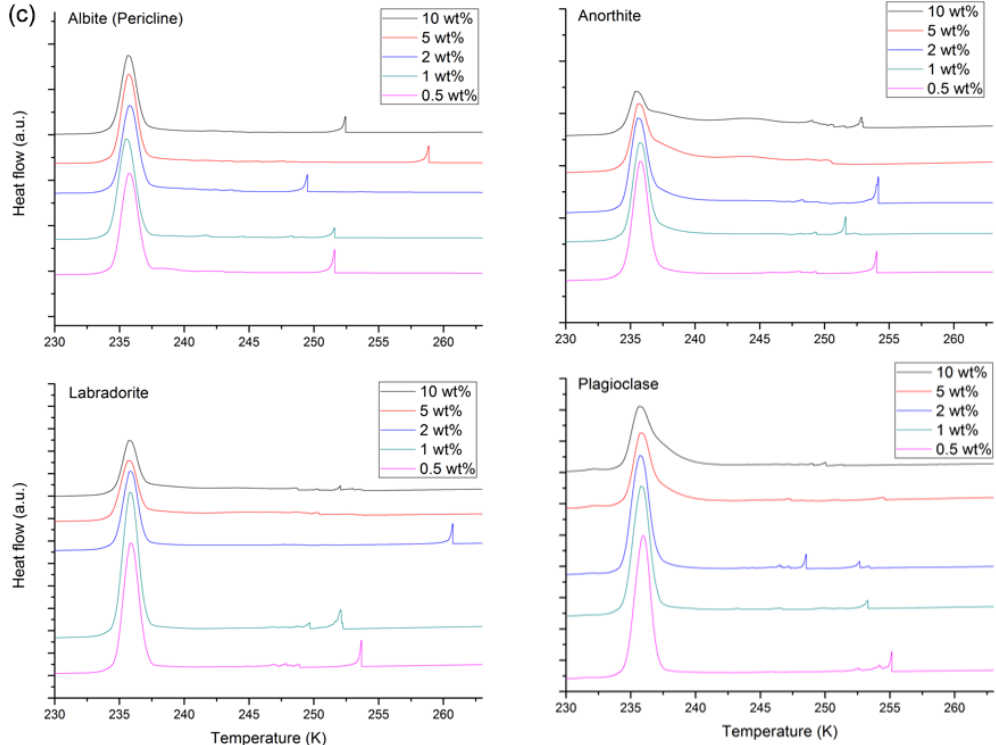
Figure 5. (a) DSC thermograms of frequently found minerals: ankerite, calcite, dolomite, dolostone, muscovite, and quartz. Suspension concentrations are given in the legend. (b) DSC thermograms of K-feldspars: adularia 1 and 2, microcline E, microcline N, orthoclase 1 and 2, sanidine. Suspension concentrations are given in the legend. (c) DSC thermograms of (Na, Ca)-feldspars: albite (pericline), anorthite, labradorite, plagioclase. Suspension concentrations are given in the